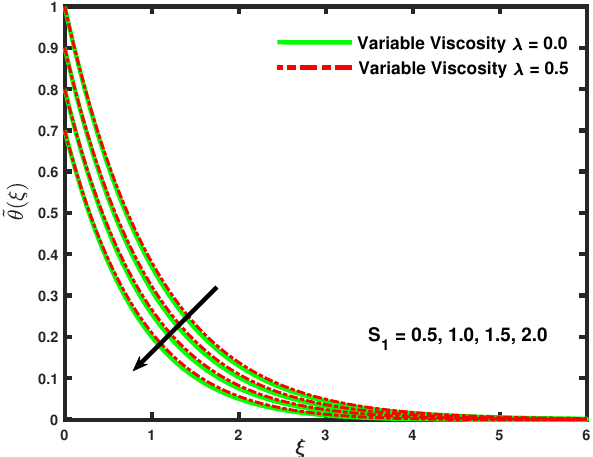
Figure 6. The influence of Thermal Stratification S 1 on Temperature profile.